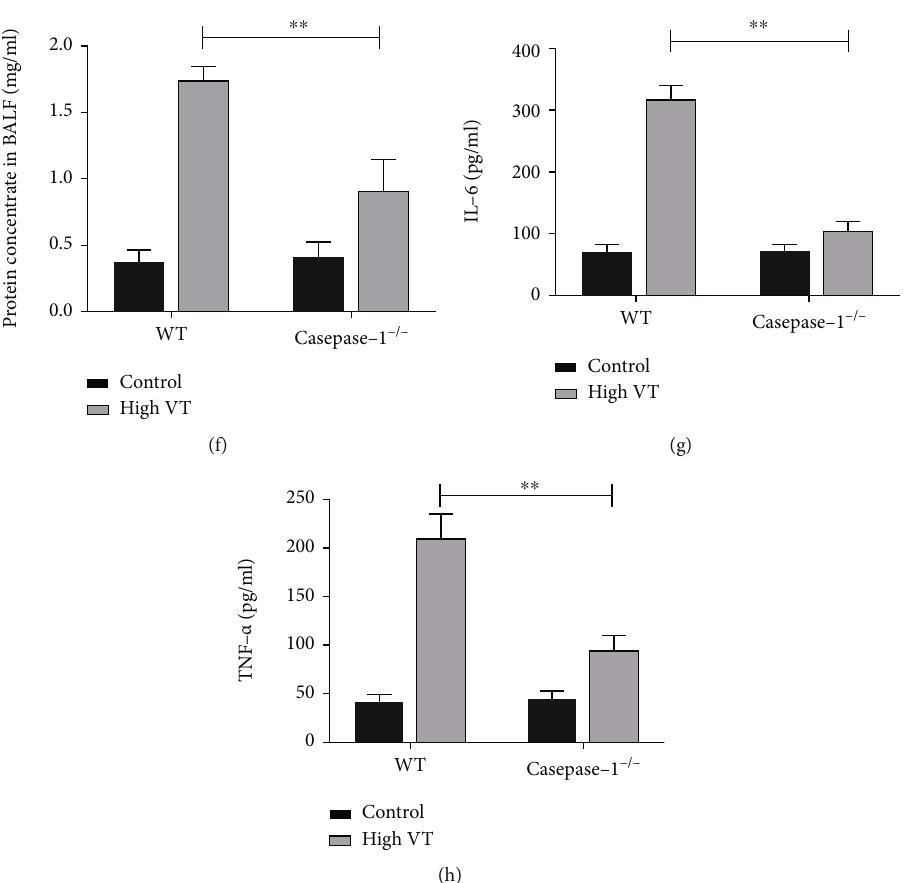
Figure 3: Caspase-1 deletion abolishes VILI and cytokine release in mice. Caspase-1 deletion alleviated the high-tidal-volume ventilation- induced lung injury measured by lung injury scores (d) for lung pathology. (a) Lung gross pathology is shown. Representative histologic sections for lung pathology (b) (magni fi cation, 20 × ) and (c) (magni fi cation, 400 × ) are shown. Caspase-1 deletion alleviated lung pathology in gross pathology (a) and HE-stained micrographs (b and c). Caspase-1 deletion reduced the wet/dry (W/D) ratio (e) and BALF protein concentration (f) in the high VT group. Caspase-1 deletion attenuated the release of IL-6 (g) and TNF- α (h) in BALF of high VT. Results are representative of three independent experiments; the results of one representative experiment are shown ( n = 5 /group, ∗ p < 0 : 05 , ∗∗ p < 0 : 01